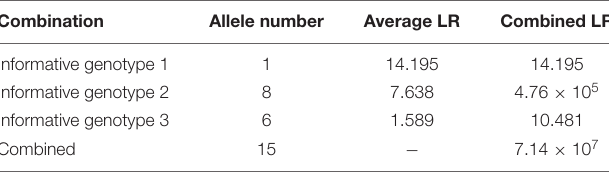
Table 5 . The match probability of the SNP-STRs ranged from 0.016 (rs9362476-SE33) to 0.185 (rs13413321-TPOX) and that of the STRs ranged from 0.016 (SE33) to 0.239 (TPOX). The power of discrimination of the SNP-STRs ranged from 0.815